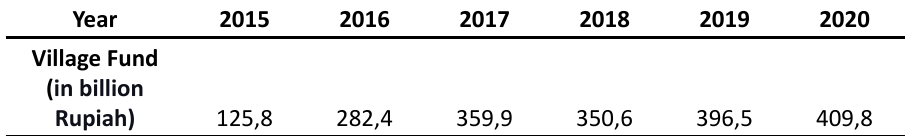
Table 1: Village Fund & Unemployment Rate for Kebumen Regency,